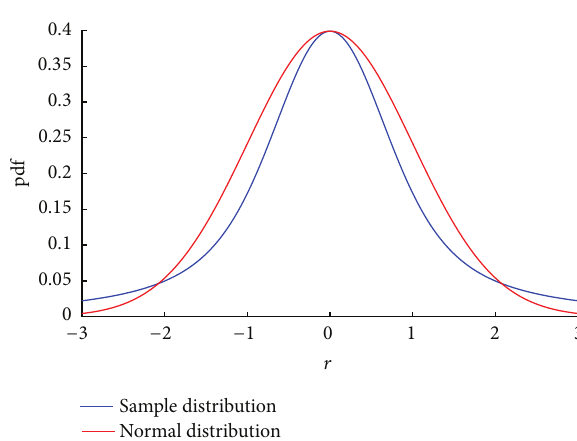
Figure 7: The shape of the theoretically distributed 𝑓(𝑟) and normal distribution for 𝜎 𝑒 = 1 .